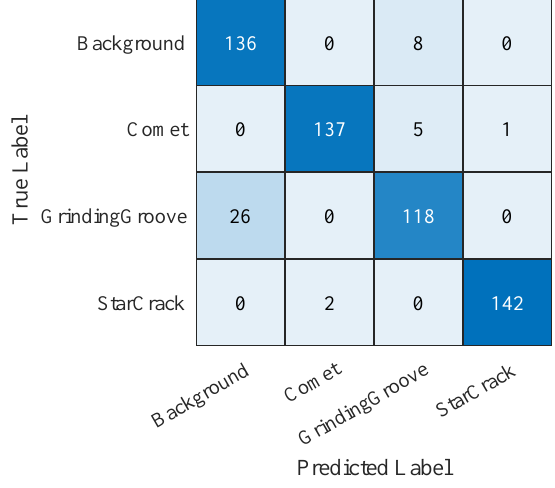
Figure 15. Confusion matrix of ‘SVM + conv3 (CNN 20)’ applied on the test samples.